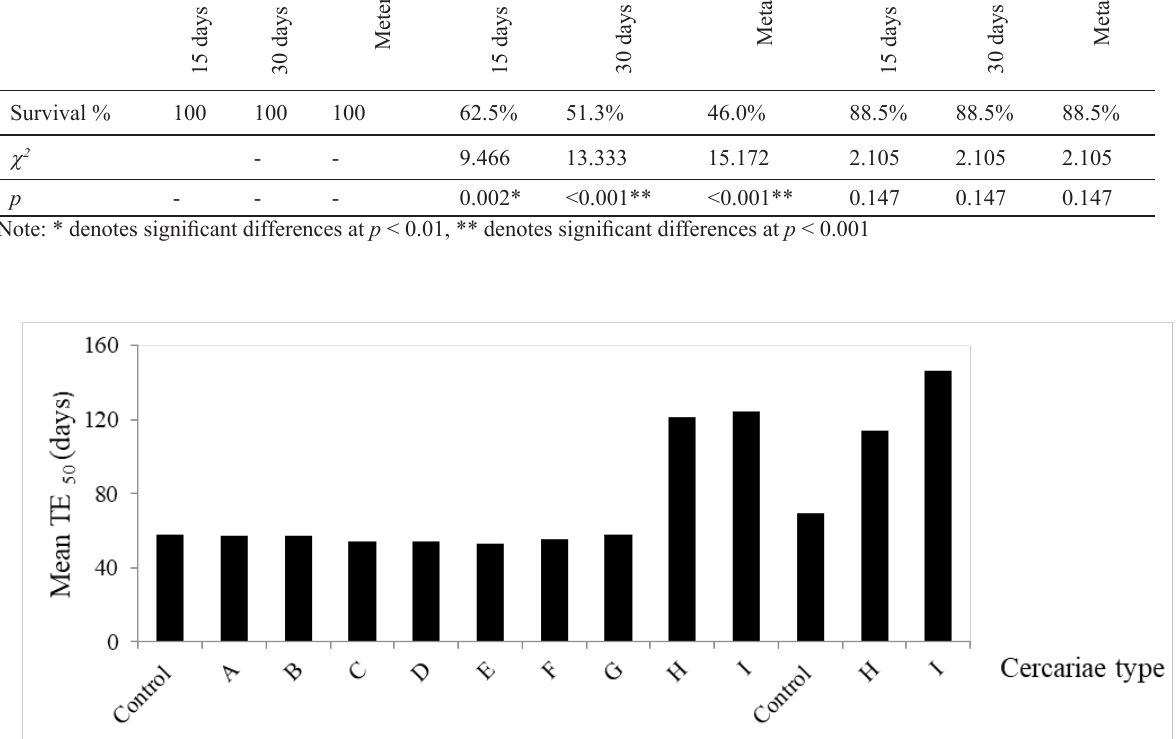
Figure 9: Time required for the forelimb emergence of half the number of tadpoles (TE types of cercariae (Cercariae types A to I) at Gosner stage 27/28 in the preliminary exposures and